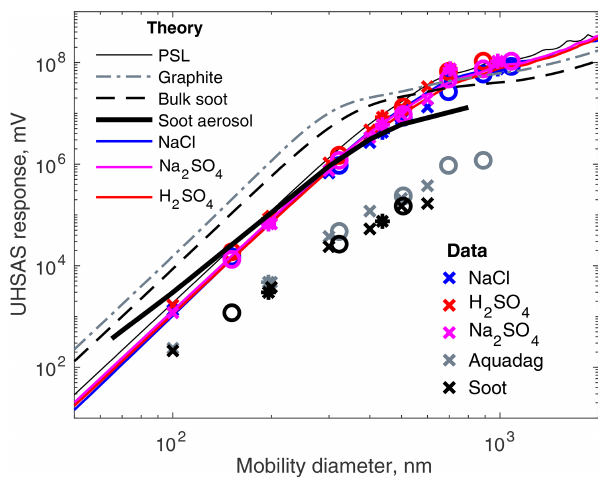
Figure 3. Scattering calculations over the collection angles of the UHSAS for particles with various refractive indexes and observed responses. Mie calculations assuming spherical, homogeneous par- ticles are shown except for the soot aerosols, which were assumed to consist of 20nm spherules as shown in Fig. 2 and discussed in Sect. 2.3.1. Measured responses from particles sized with a long DMA are shown as symbols, with “ × ”, “ ◦ ”, and “ ∗ ” representing singly, doubly, and triply charged particles, respectively. For test particles the y axis is the signal from the peak height detector. For the theoretical curves it is V from Eq. (A7), with C opt determined from the peak height of sub-300µm PSL calibration spheres. The “soot” data are from the same fullerene soot lot as in Gysel et al. (2011).